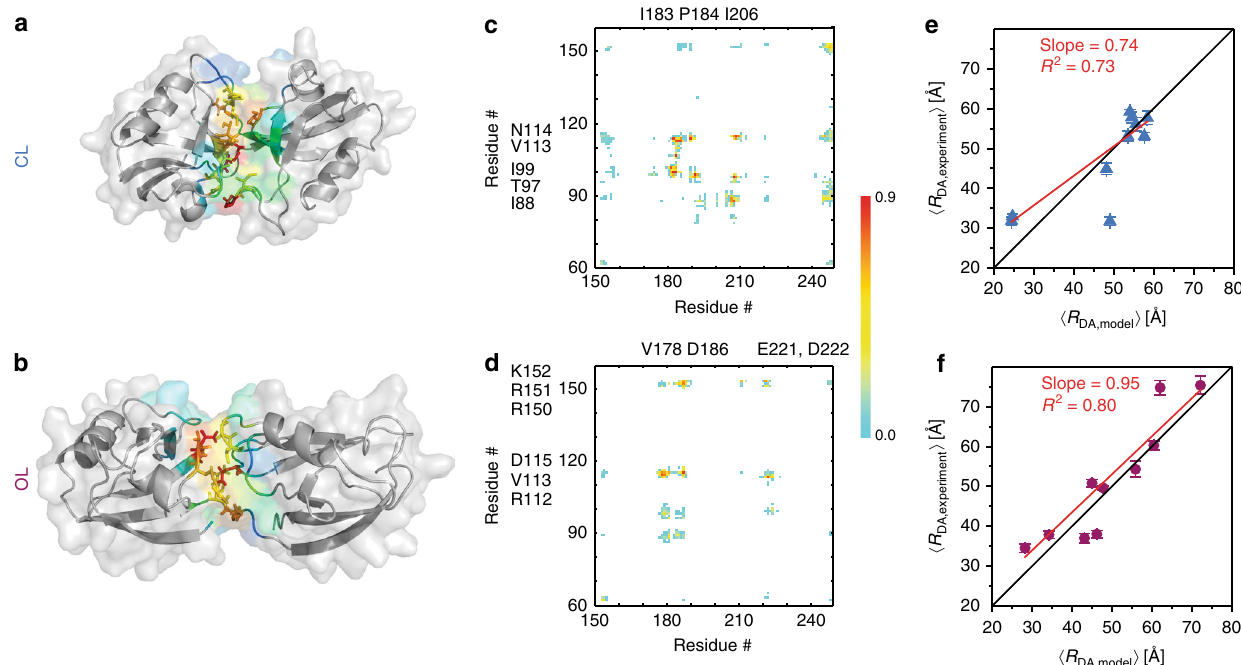
Fig. 4 Representative structures, contact maps and correlation between experimental and DMD simulated interdye distances. a Cartoon representation for the closed-like (CL) state, which has the shorter interdomain distance and a larger contact interface. PDZ domains are shown in cartoon representation with a transparent surface. Interfacial residues are colored according to their contact frequency (cyan to red denoting low to high frequency). b Representative structure for the open-like (OL) state with increased interdomain separation and smaller contact interface. Rendered and colored as in panel a . c The interdomain contact frequency map per residue for the conformational ensembles of the CL state. Contact frequency uses same color palette as in panels A and B; no contact white, low contact probability cyan and high contact red. d The interdomain contact frequency map for the OL state. The color palette is the same as in ( c ). Residues with the highest interdomain contact frequencies are highlighted along the axis for each PDZ domain. e , f Measured interdye distances from eTCSPC ( y -axis) plotted against the simulated interdye distances for the representative models shown in ( a ) and ( b ) ( x -axis). e Distances for the CL state plotted against those for the second-most populated state in eTCSPC. f Distances for the OL state plotted against those for the most populated state in eTCSPC. Data was fi t to a line to extract the slope and correlation. Error bars in ( e ) and ( f ) correspond to the uncertainty on the measured distances shown in Supplementary Table 1 using an error propagation rule (Supplementary Eq.